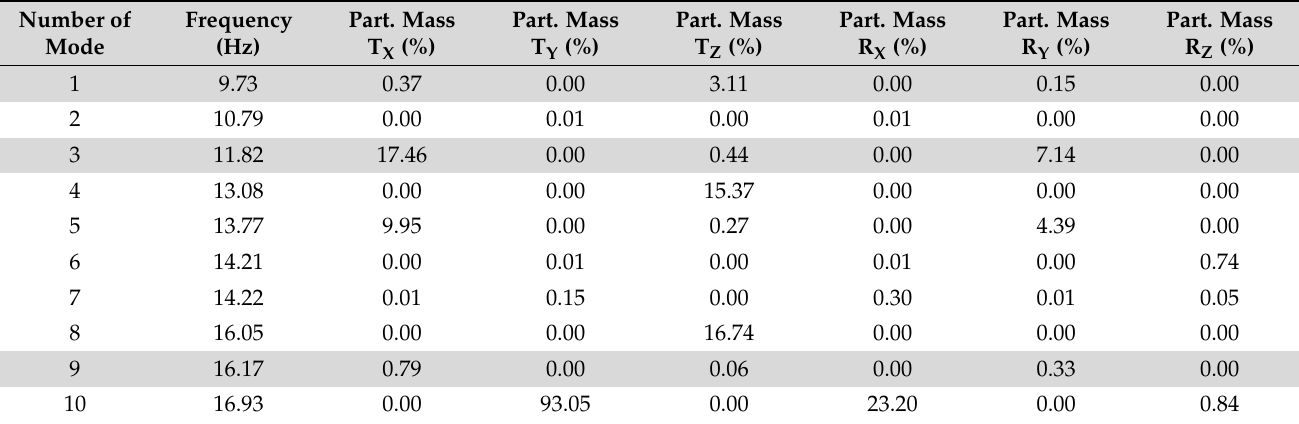
Table 8. Main modal frequencies and participating masses obtained by the nominal model.